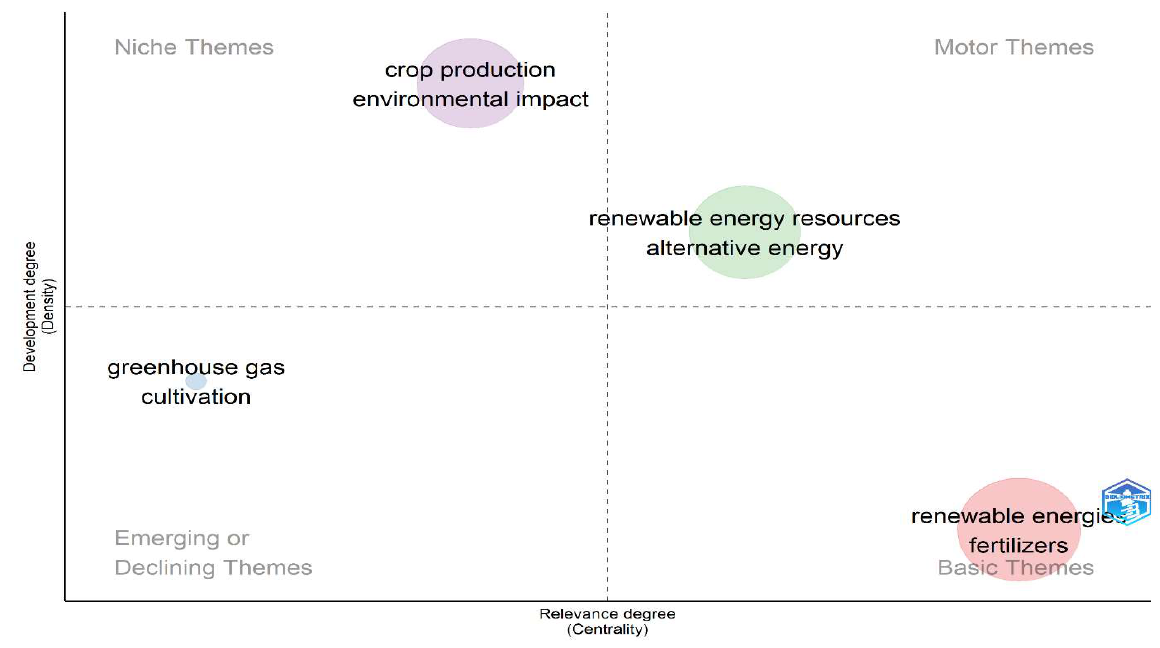
Figure 7. Thematic map (2019–2022). Source: created by the authors.